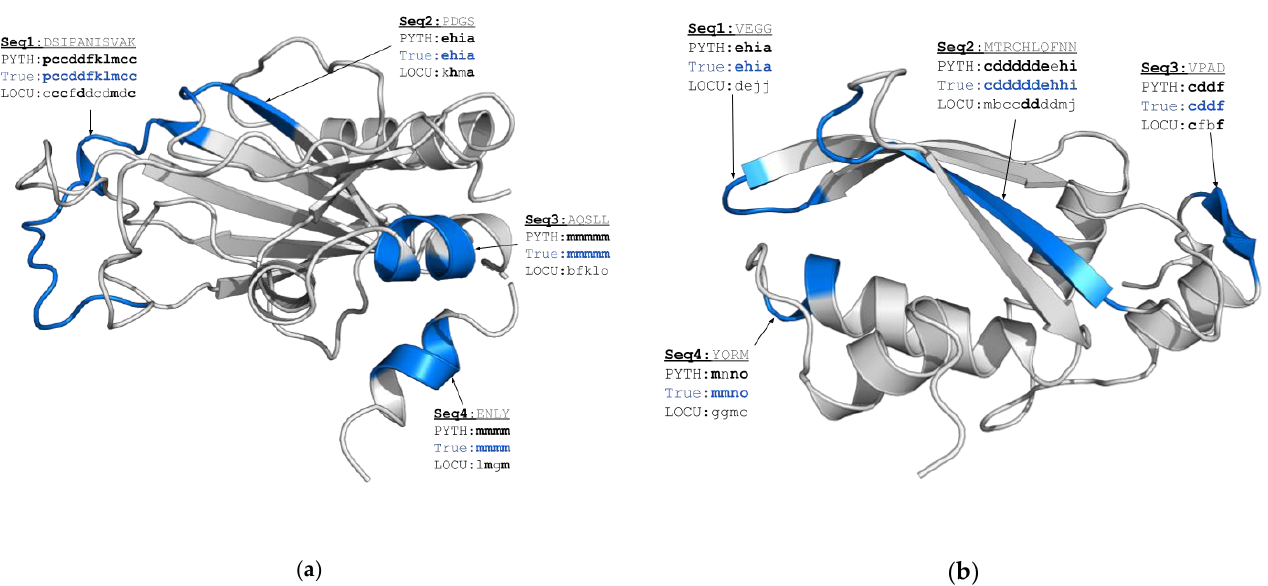
Figure 4: Comparison of the PB prediction results for two CASP14 targets: 7k7wA ( a ) and 6uf2A ( b ). In blue, we highlight protein regions in which we have observed the most pronounced difference in PYTHIA and LOCUSTRA predictions. The corresponding amino acid sequences are given in gray and the correctly predicted PBs are given in bold.